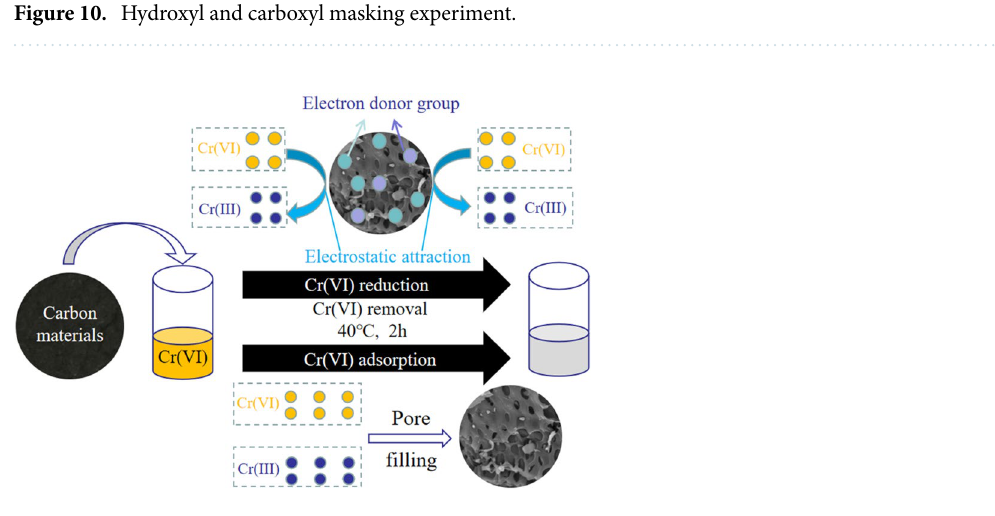
Figure 11. Removal mechanism of Cr(VI) by OS-CS